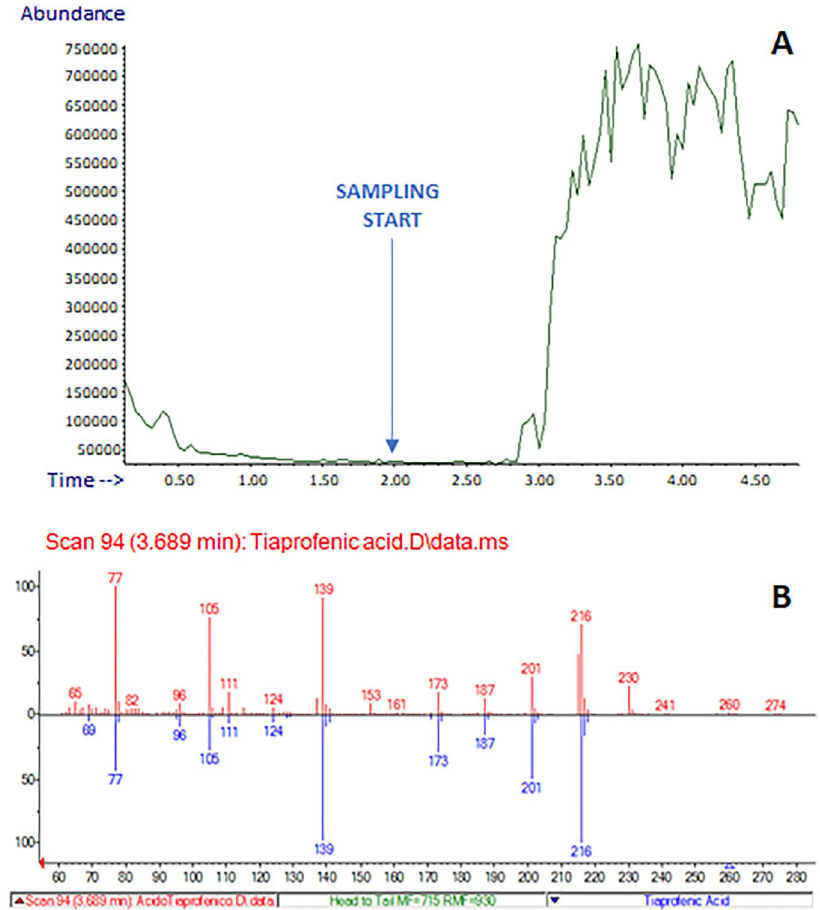
Figure 2. ( A ) Analysis of a Surgamyl tablet: TIC; ( B ) NIST library spectrum matching: red, experimental spectrum; blue, library spectrum. The arrow indicates the sampling